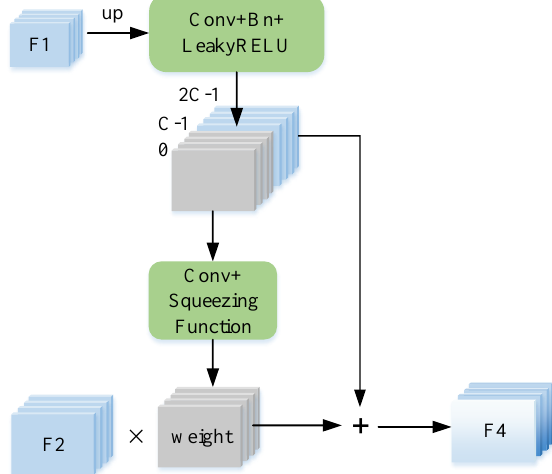
Figure 7. Process of MaskFPN. The information output from the feature map F1 after the convolution operation is dilated by a factor of 2 channel-wise. The information from the [0 ~ C-1] channel generates the weight map by the squeezing function. The information from channel [C ~ 2C-1] is used for feature fusion.